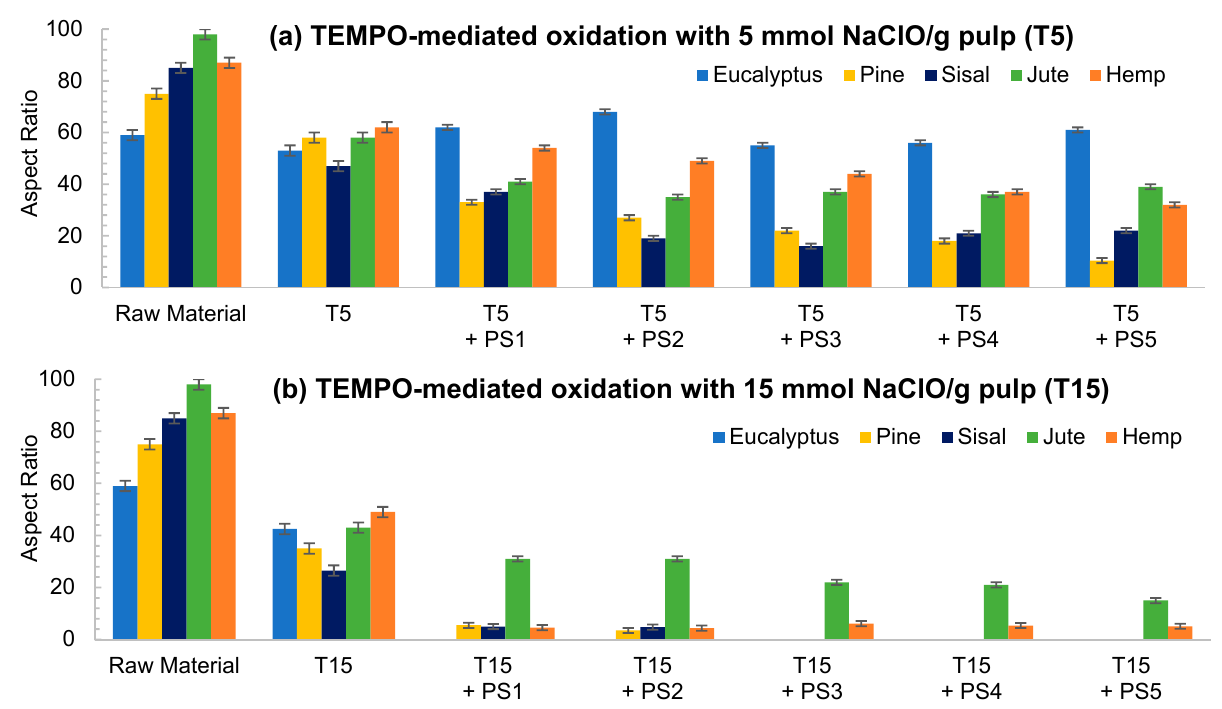
Figure 6. Evolution of aspect ratio in CNFs with TEMPO-mediated oxidation pretreatment. ( a ) TEMPO-mediated oxidation with 5 mmol NaClO/g pulp (T5); ( b ) TEMPO-mediated oxidation with 15 mmol NaClO/g pulp (T15).